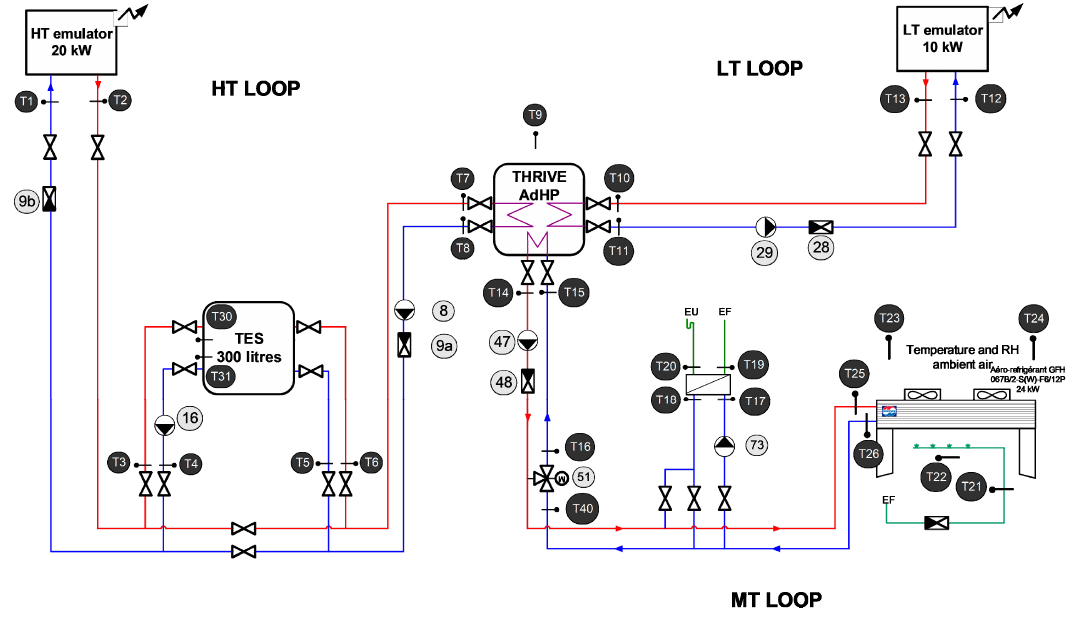
Figure 3. Hydraulic Scheme of the adHP test bench.